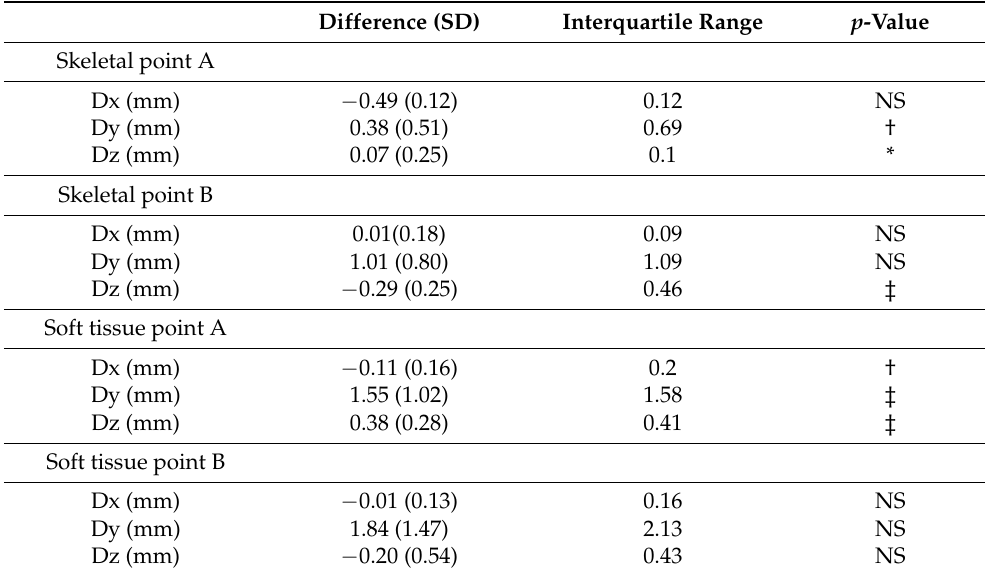
Table 1. Mean changes of skeletal and soft tissue points A and B in three directions